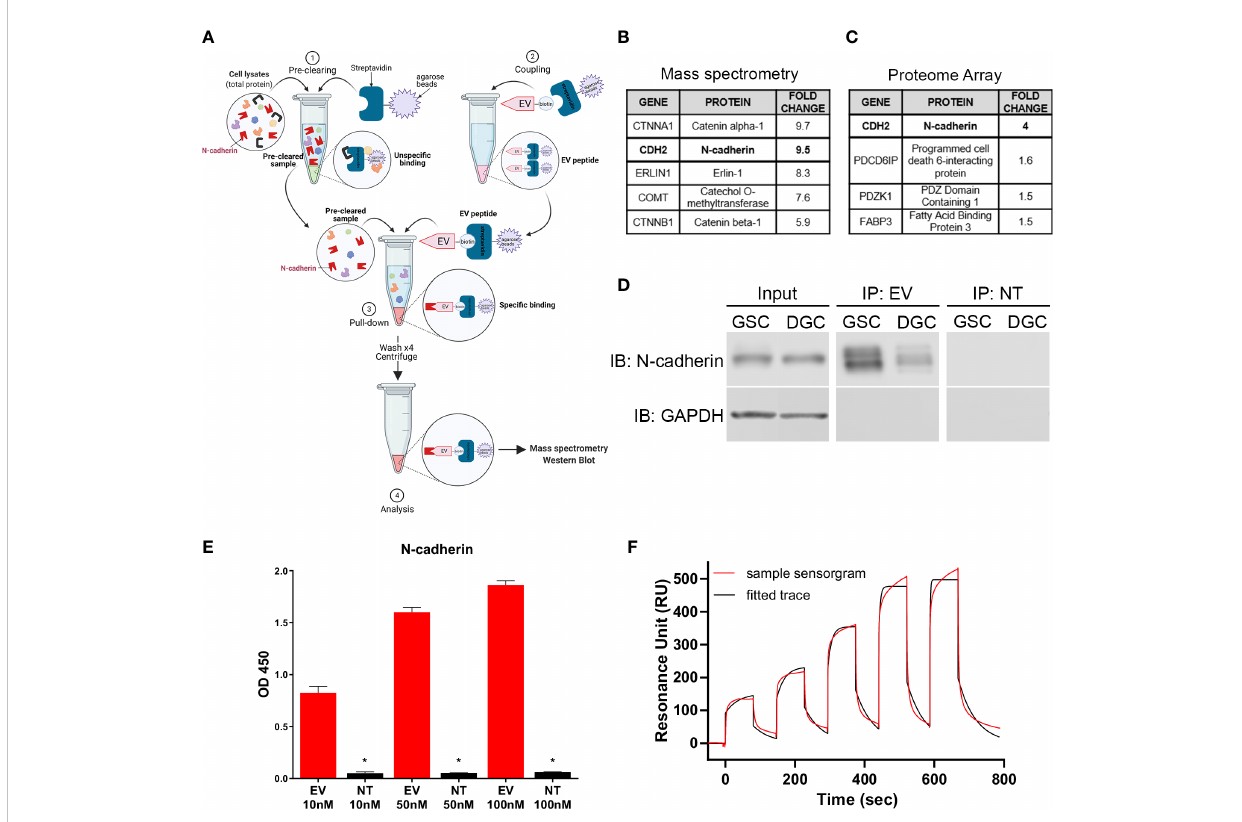
FIGURE 3 N-cadherin as the target of EV peptide. (A) Diagram of the peptide pull-down assay performed with EV-biotinylated peptide on GSCs and DGCs. (B) Highest scoring proteins from EV binding to GSC surface proteins identi fi ed by peptide pull-down followed by mass spectrometry analysis and (C) human proteome array. (D) Immunoblot results from the peptide pull-down, demonstrating a stronger binding to N-cadherin in GSCs compared to DGCs. (E) ELISA displaying the binding of different concentrations of EV or NT to N-cadherin. The stars show the signi fi cant differences between EV and NT for the same concentration, * = p < 0.005. Data in quadruplicate. (F) Surface plasmon resonance single cycle kinetic titration run showing the binding of EV peptide with N-cadherin using Biacore T200. Data were performed in